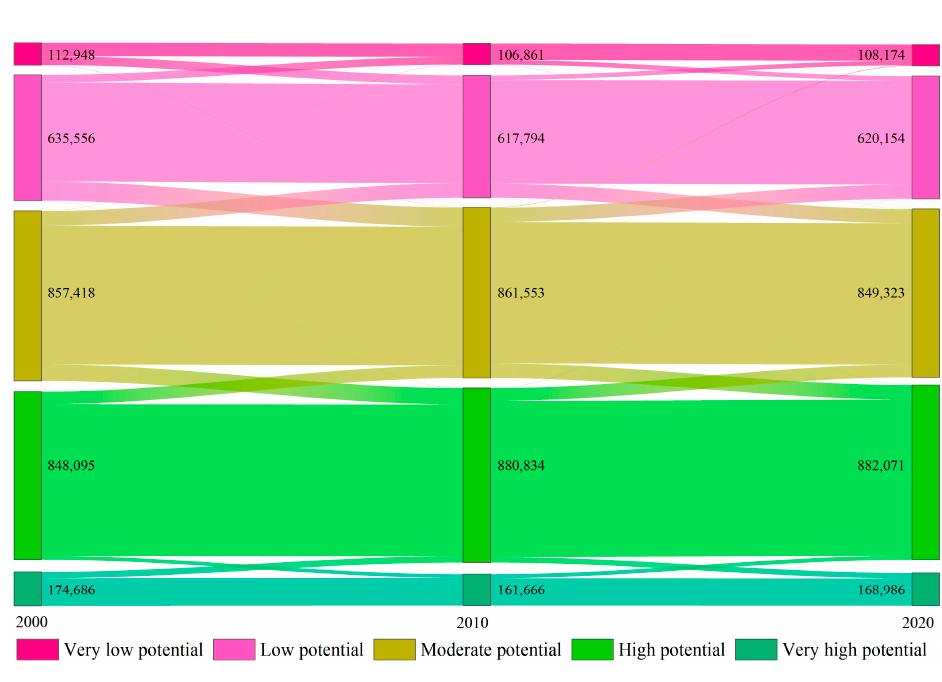
Figure 3. INRPI transition from 2000 to 2020.